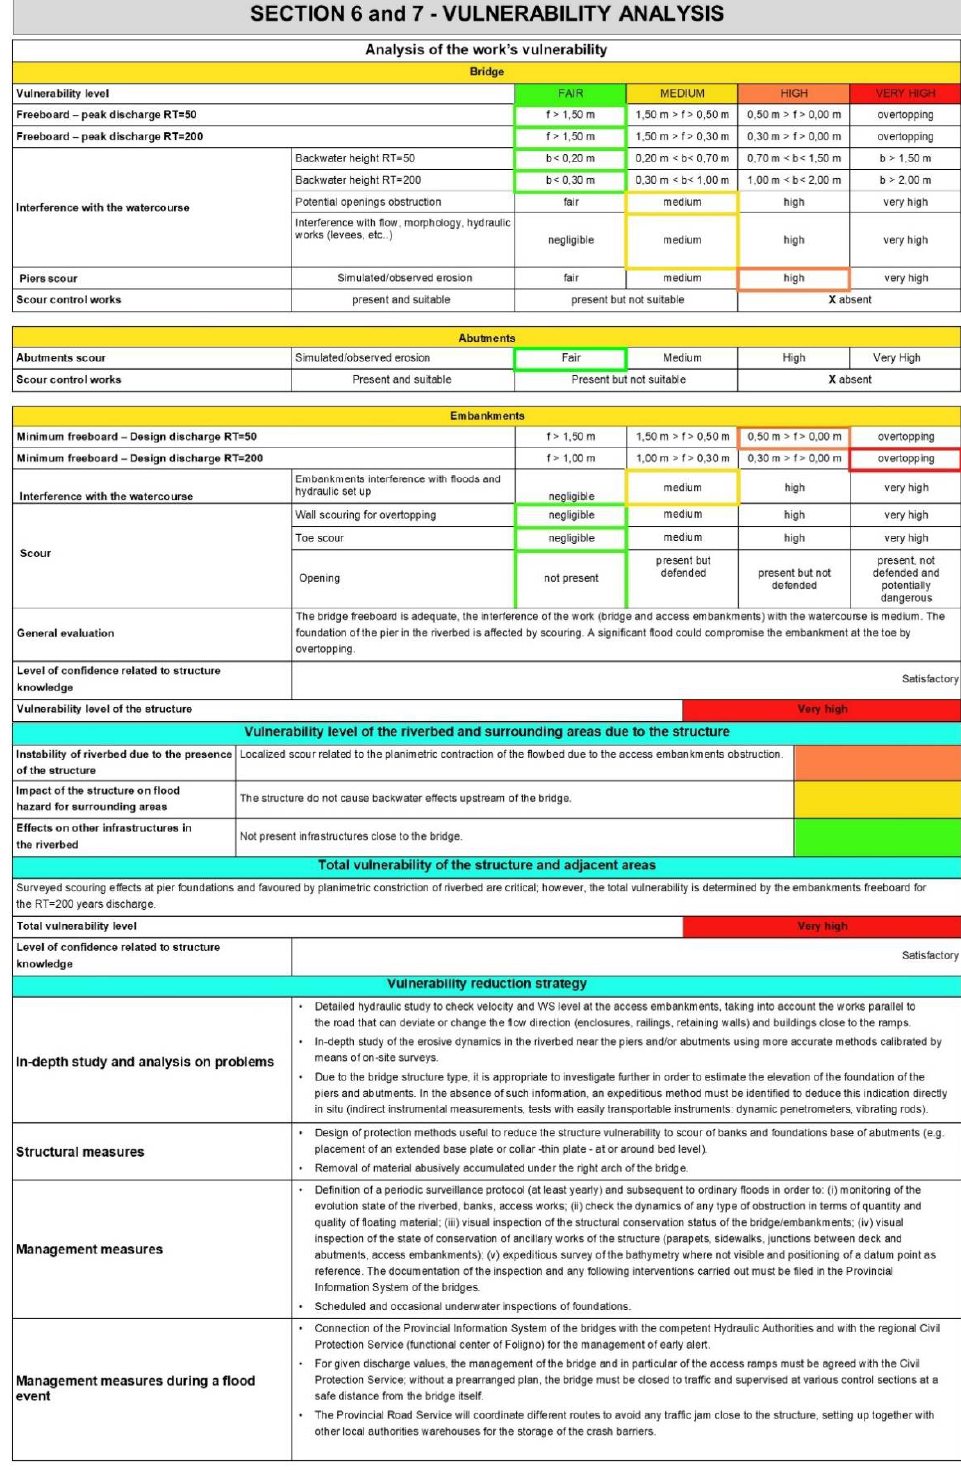
Figure A4. Synoptic table for Sections 6 and 7.